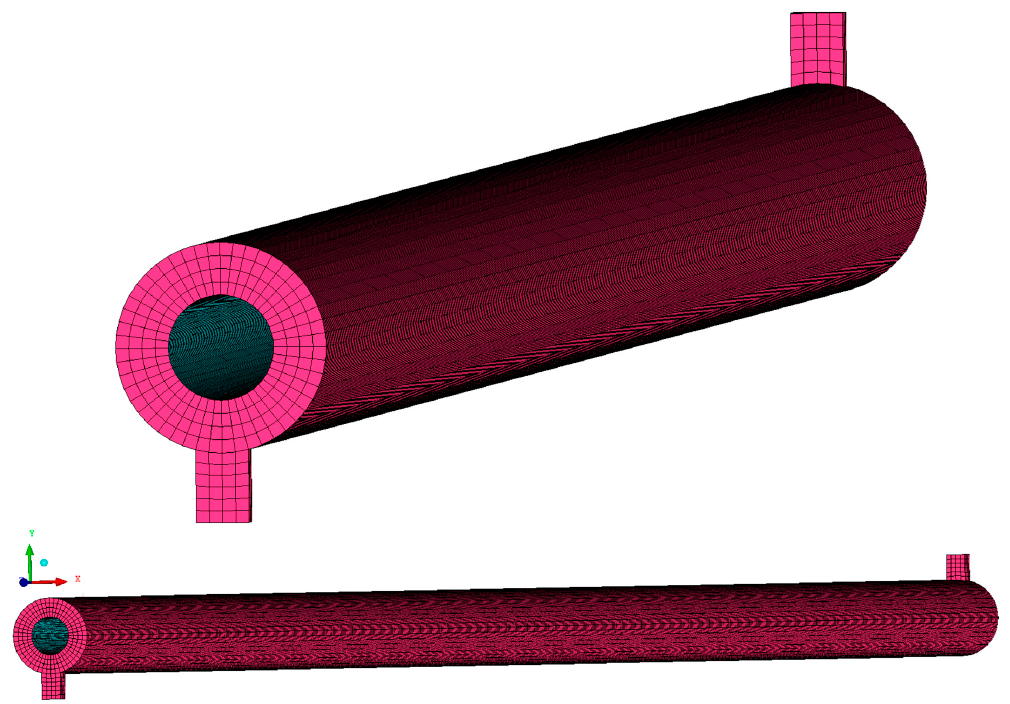
Figure 3. Geometric representation of the 3D separation module: ( a ) membrane in the external tube; ( b ) membrane in the internal tube.